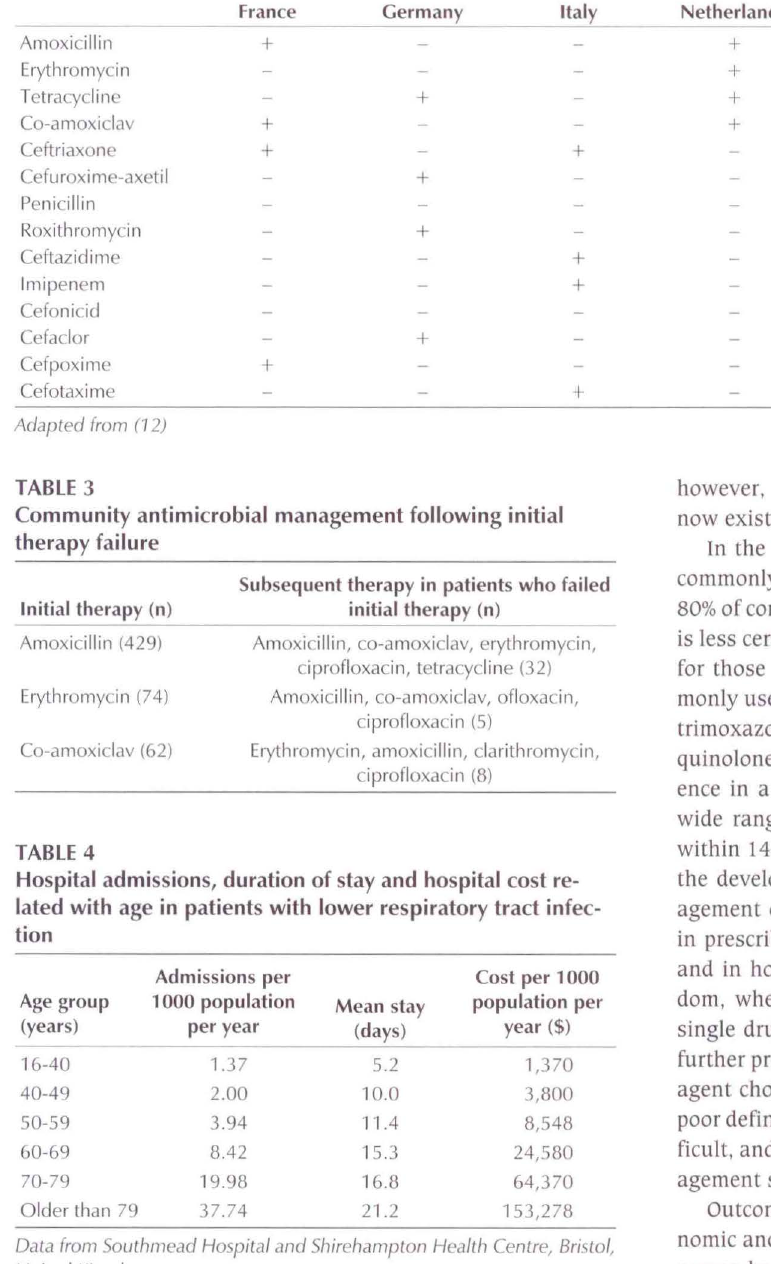
Treatment of community-acquired pneumonia in the community: Top four agents used for out-patient management in selected European countries